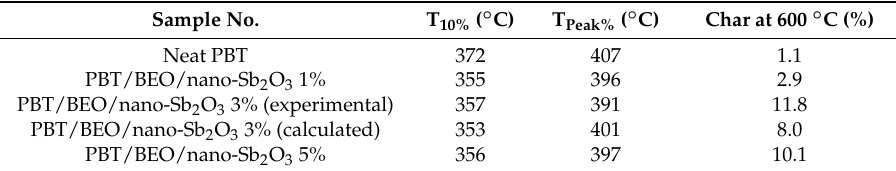
Table 4. Thermogravimetric analysis (TGA) data of the neat PBT and its nanocomposites under